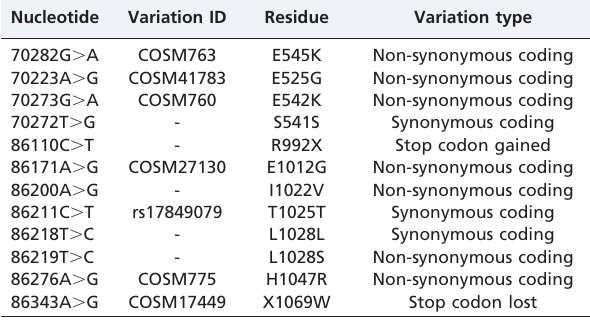
Table 2 - Observed variations in PIK3CA mutations in exons 9 and 20 in breast tumors (n=